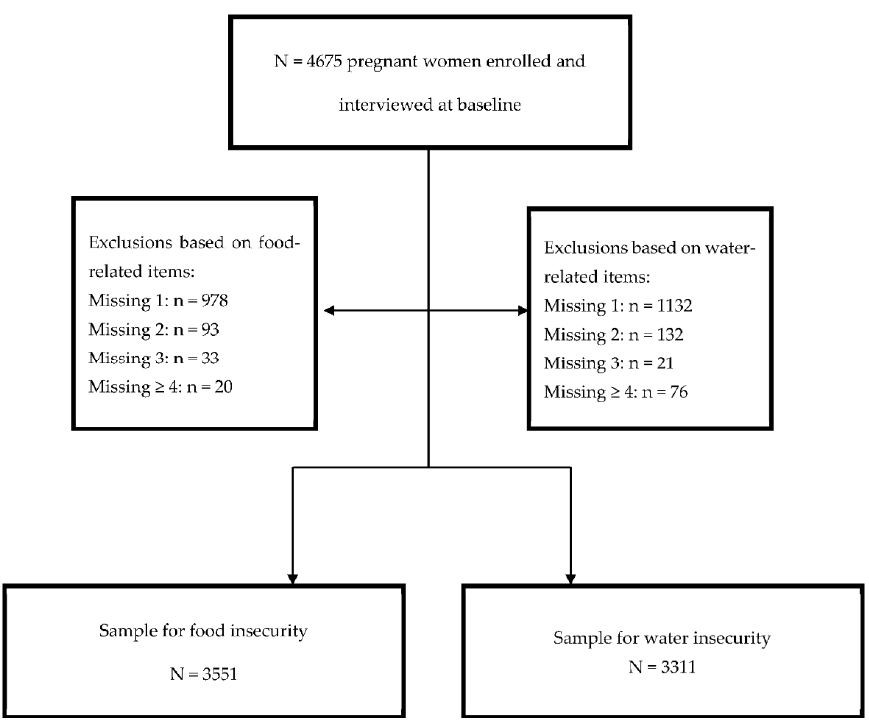
Figure 1. Sample selection for FI and WI factor analyses.